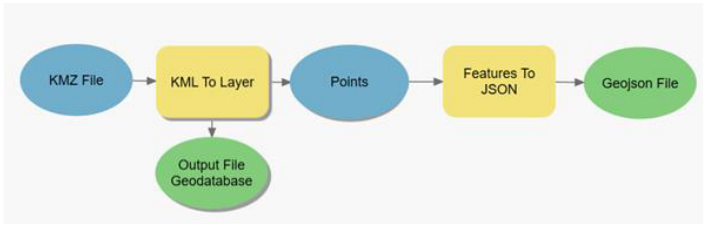
Figure 6. Processing KMZ files on ArcGIS Pro. (Created with ArcGIS Pro model builder).